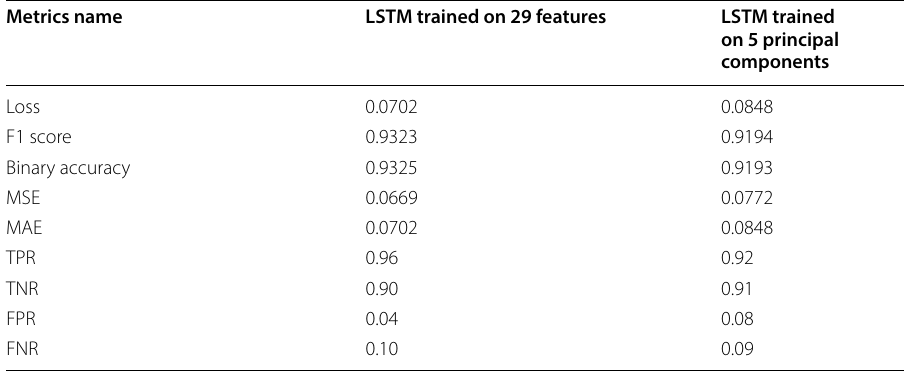
Table 9 Proposed model performance comparison—with and without